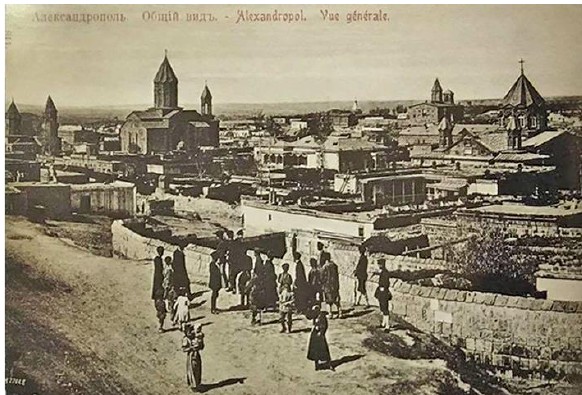
Figure 2. General view of Alexandropol. Postcard from 1900s.